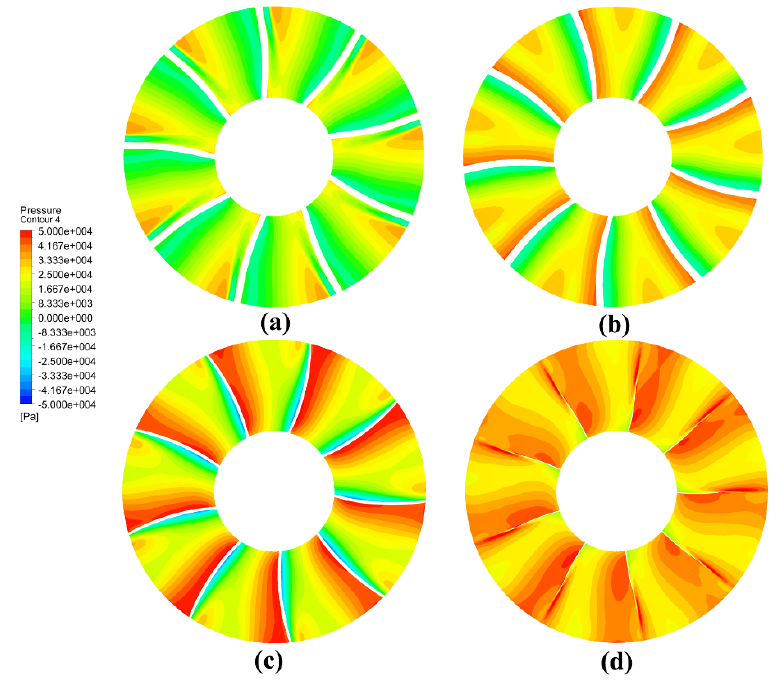
Figure 33. Axial section pressure distribution of rotor designed by inverse design method ( a ) 20% rotor channel, ( b ) 40% rotor channel, ( c ) 70% rotor channel, and ( d ) 90% rotor channel.